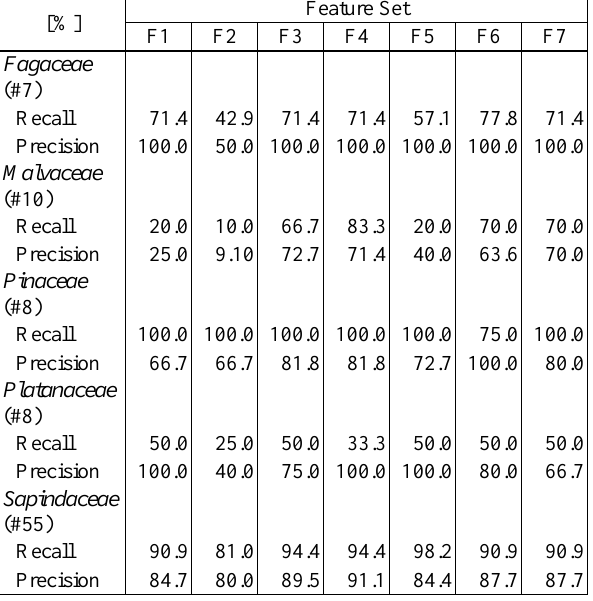
Table 5. Recall and precision differentiated by feature set and tree family. The total number of trees is added in brackets.